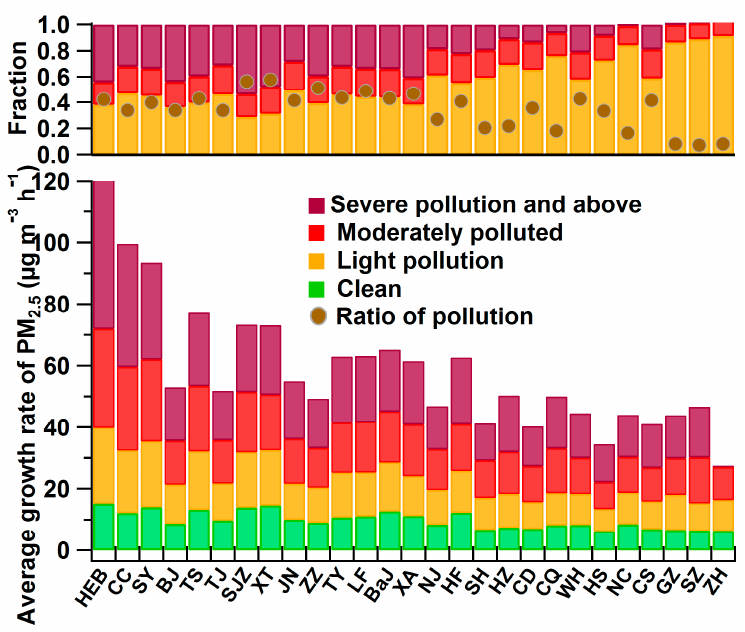
Figure 4. The average growth rate of PM 2.5 (+ ∆ PM 2.5 ) at each representative station during clean, light pollution, moderate pollution and heavy pollution before growth ( below ) and the proportion of PM 2.5 above 75 µ g m − 3 before the growth and the proportion of light, moderate, and heavy pollution ( upper